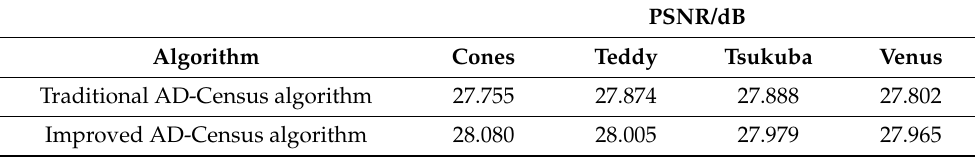
Table 3. Comparison of algorithms’